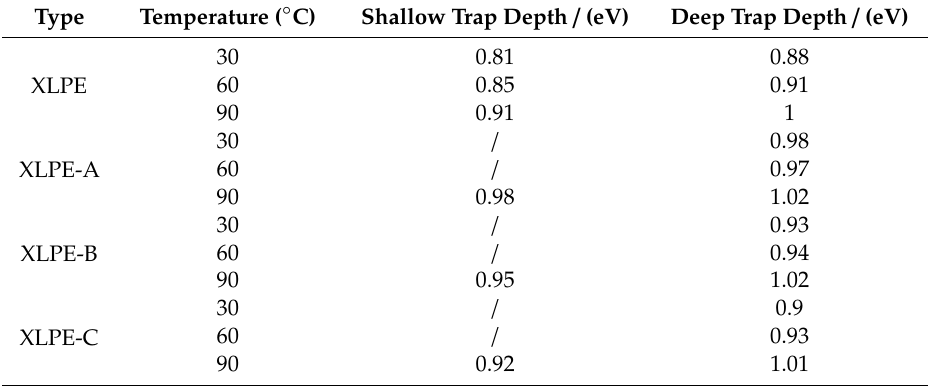
Table 2. Cross-linked polyethylene (XLPE) and its polycyclic compounds composites trap